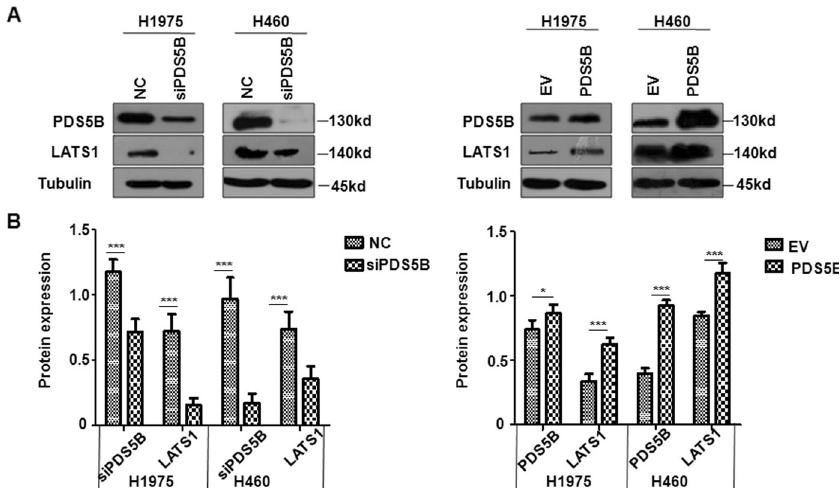
Fig. 3 PDS5B regulates LATS1 expression. A The expression of PDS5B and LATS1 was examined by western blotting in H1975 and H460 cells after PDS5B modulation. EV empty vector, PDS5B PDS5B cDNA. NC nonspeci fi c control siRNA, siPDS5B PDS5B siRNA. NC and EV groups are the